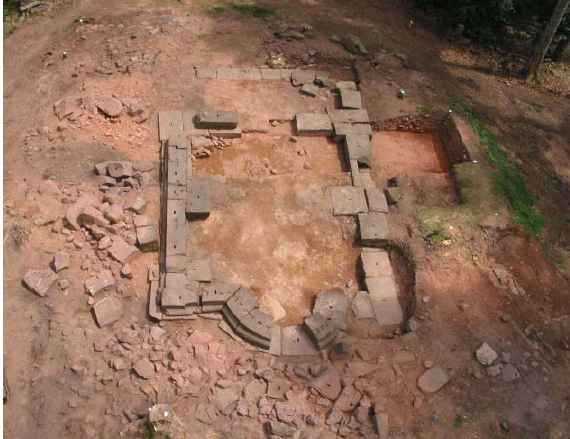
Figure 1: The monument opened during the excavations (2006) While only foundation lines were recognized, excavations at the beginning of the 21st century uncovered several hundred blocks and fragments of architectural blocks. This situation reflects the fact that the recovery of materials had favoured simple blocks and left all the complex blocks, more difficult to reuse, on